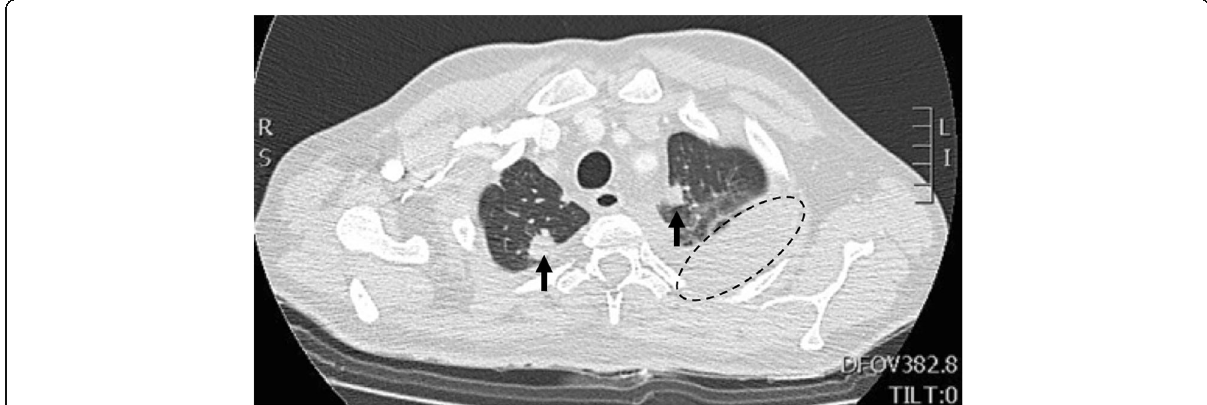
Fig. 4 Pulmonary involvement in GPA. Bilateral hyperdense pulmonary nodules (black arrows) located in both lung apices with bilateral pleural effusion (black circle), associated with pericardial effusion and pre-capillary pulmonary